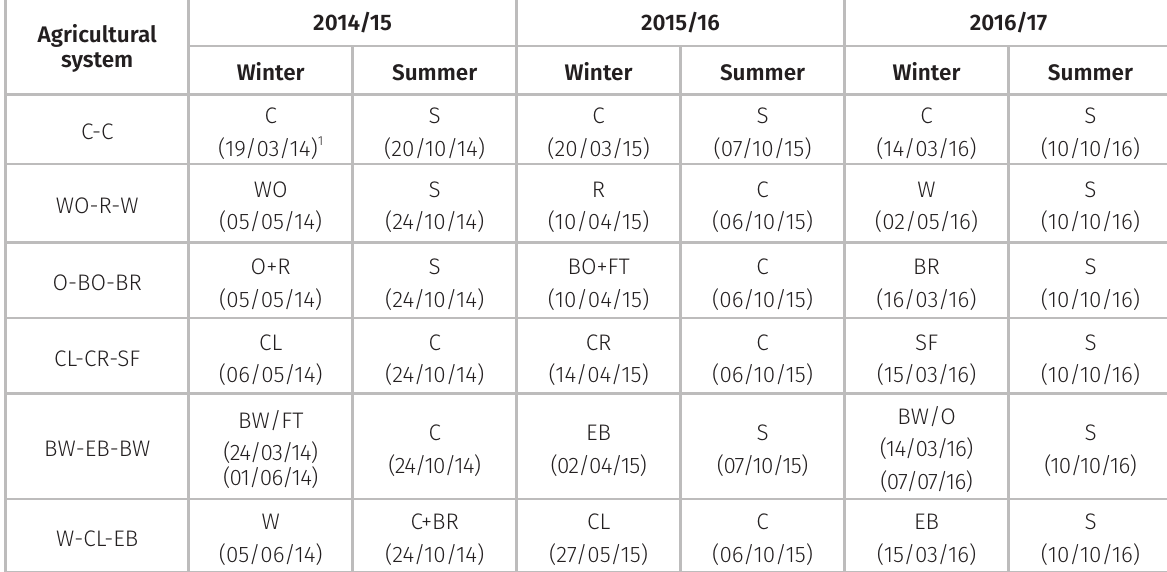
W: wheat. S: soybeans. O: oats. BO: black oats. C: corn. WO: white oats. EB: edible beans. FT: forage turnip. R: rye. CR: crambe. SF: safflower. CL: canola. BW: buckwheat. BR: brachiaria grass. 1 The information in parentheses refers to the planting dates of each crop. / Represents crops grown individually, one after the